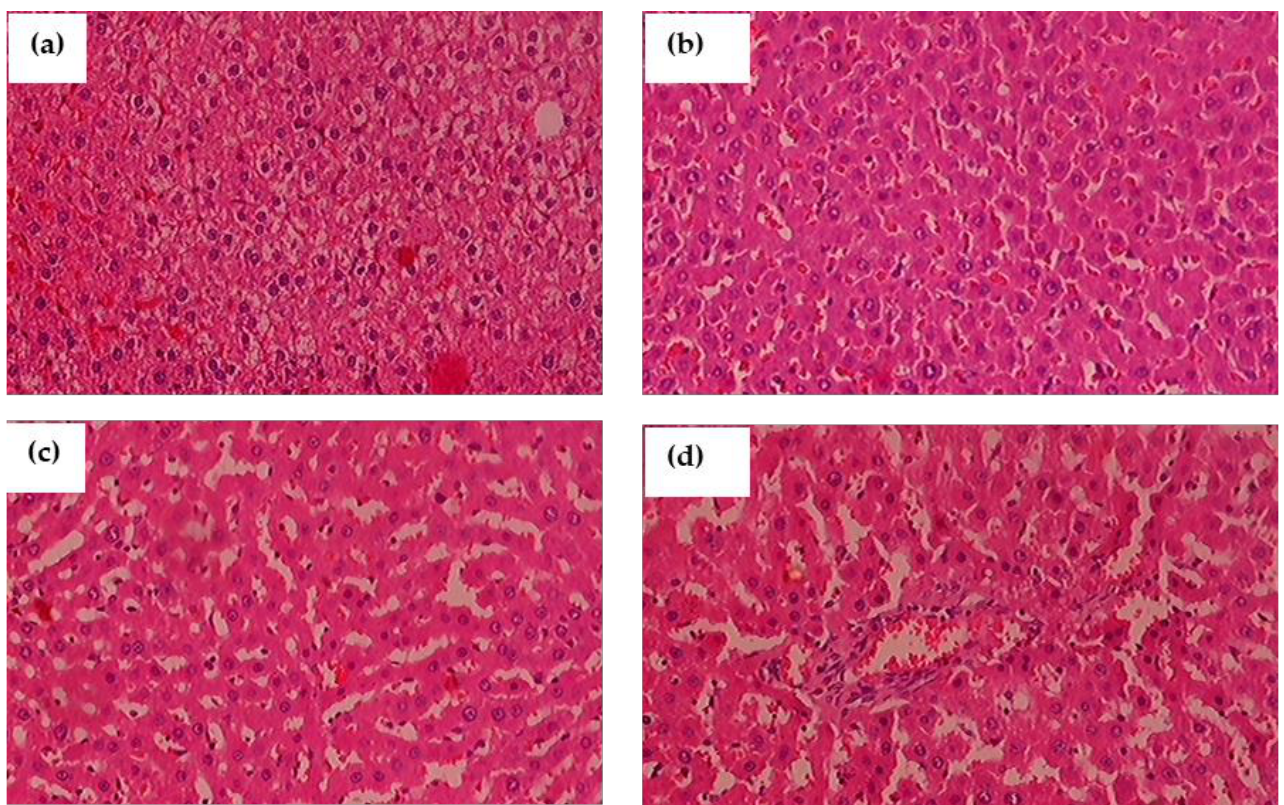
Figure 12. ( a – d ): The impact of glyphosate exposure on liver histopathology of experimental animals using hematoxylin and eosin (H&E) stain. ( a ) In normal rats, the hepatocyte nuclei are round and located inside the cells; ( b ) glyphosate-exposed rats (50 mg/kg b.wt.) showed a slight change in hepatocyte morphology when compared to control rats as the white patches around the nuclei depict lipid vesicles present inside the hepatocytes; ( c ) glyphosate-treated rats (100 mg/kg b.wt.) showed a significant fibrosis architecture of the liver with moderate lipid vesicles when compared to control rats; and ( d ) When compared to control rats, glyphosate (250 mg/kg b.wt.) rats showed elevated levels of liver fibrosis and inflammatory cells with large scale of white patches, demonstrating glyphosate toxicity in the liver.